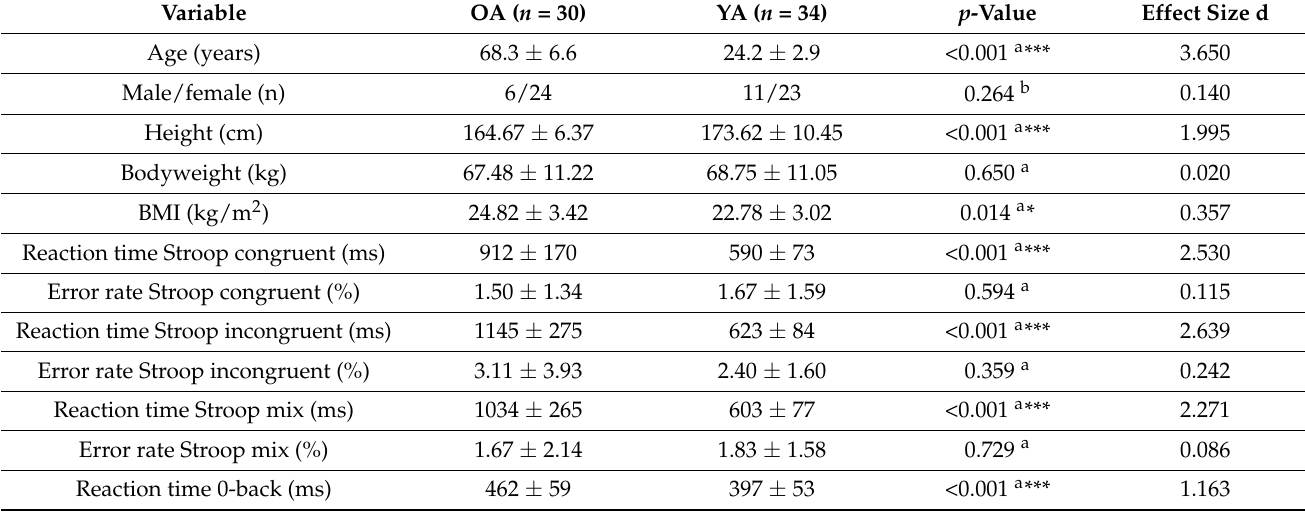
Table 1. Demographic and cognitive data (Mean ±